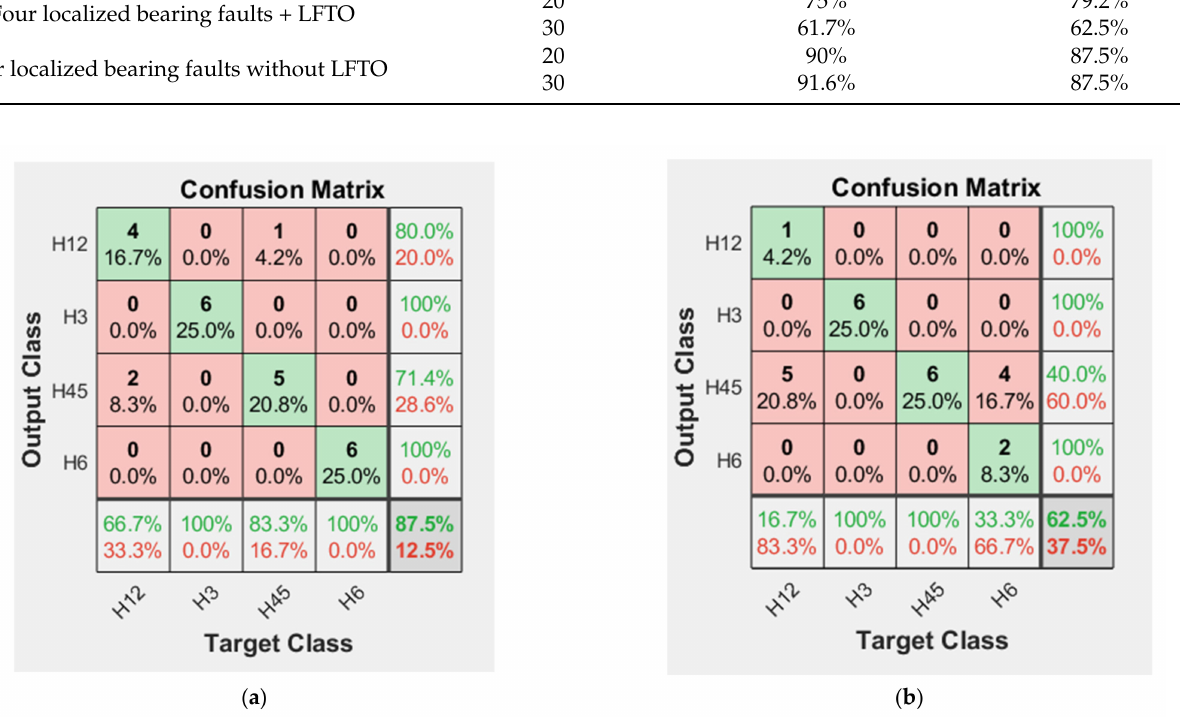
Figure 18. Confusion matrices (test set) for the classifications with four classes (spectrograms with decimation factor of 30): ( a ) four localized bearing faults and ( b ) four localized bearing faults +